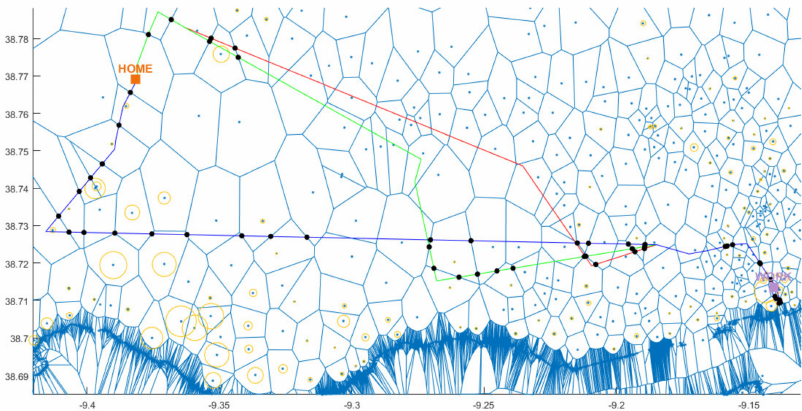
Figure 10. An example showing points (marked with black solid circles) on the visited cell tower’s Voronoi boundaries that each route passes